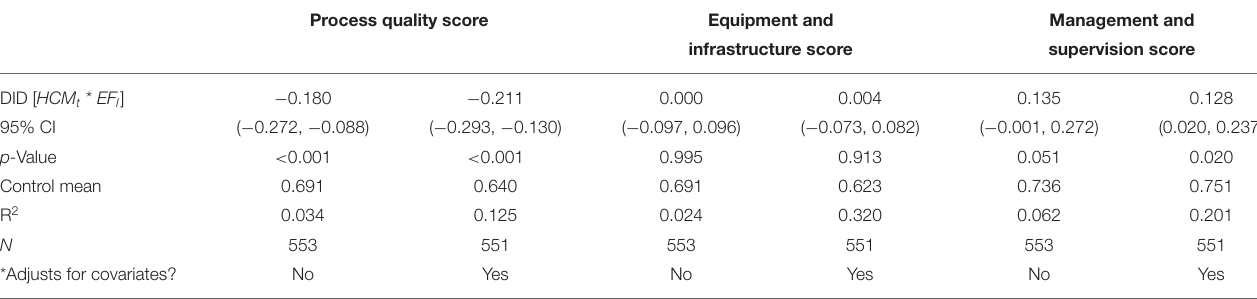
TABLE 10 | The impact of conflict exposure on ANC quality.